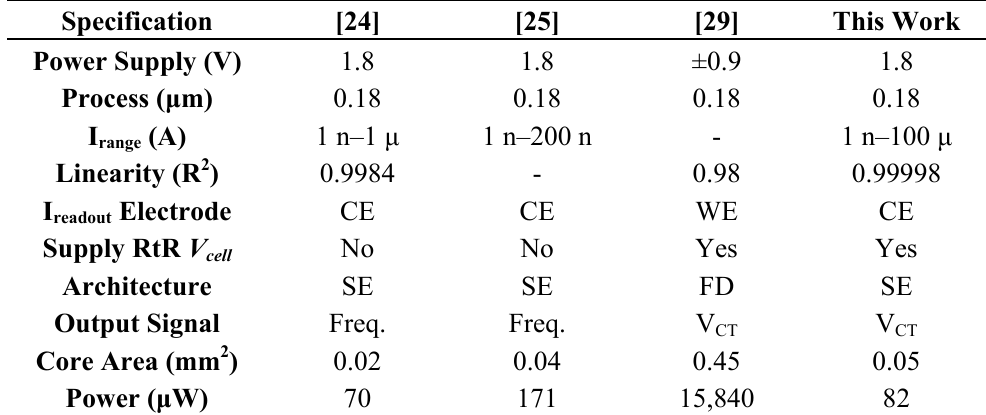
Table 3. Specification comparison of the proposed